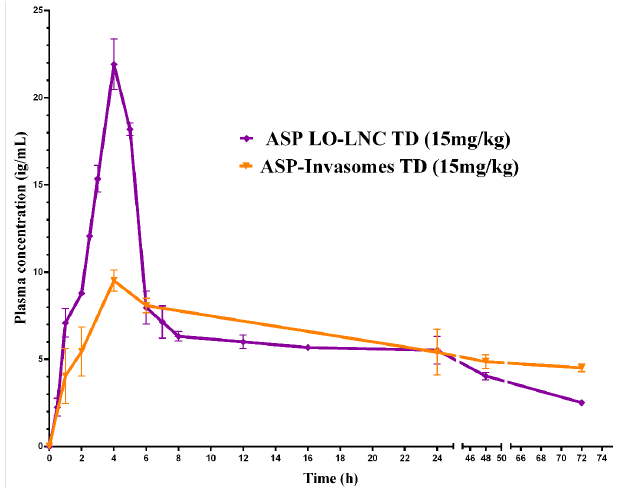
Figure 9. In vivo plasma profile of asenapine-loaded lipid nanocapsules (F22-AS) and invasomes (F2-AS) for transdermal drug delivery.